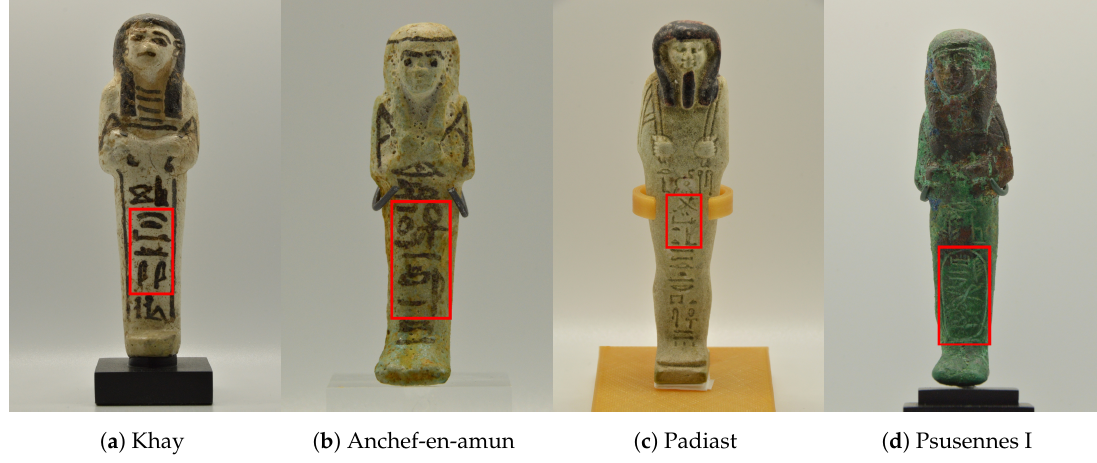
Figure 9. Manual labelling of hieroglyph names for the HN. Private